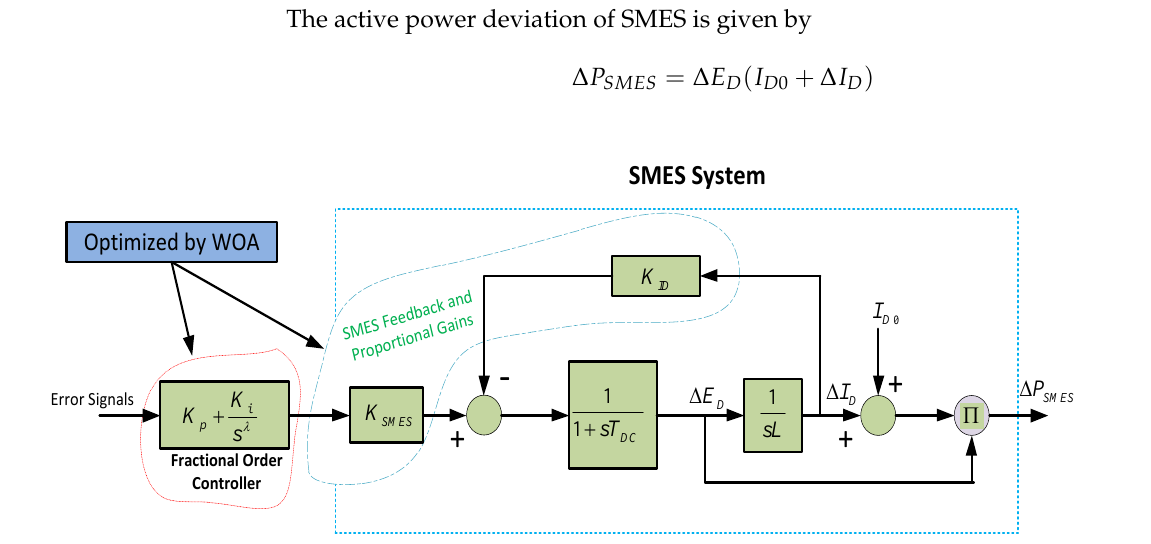
Figure 4. Dynamic model of SMES along with FOC.